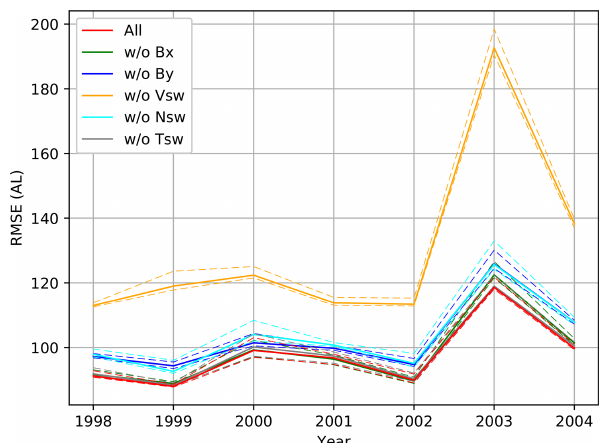
Figure 3. RMSE in each year for the various synthetic AL indices with the effect of one of the solar-wind parameters excluded.